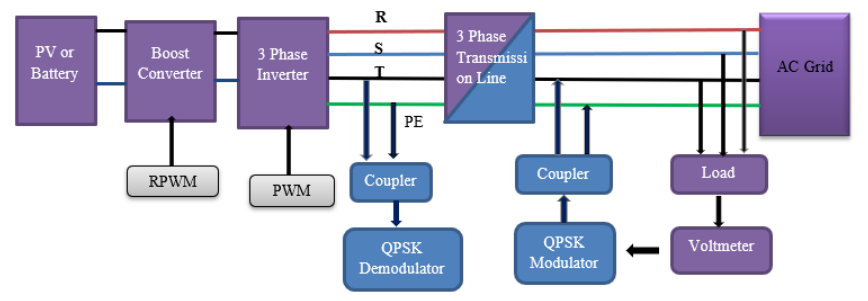
Figure 1. Block diagram of the PLC system under